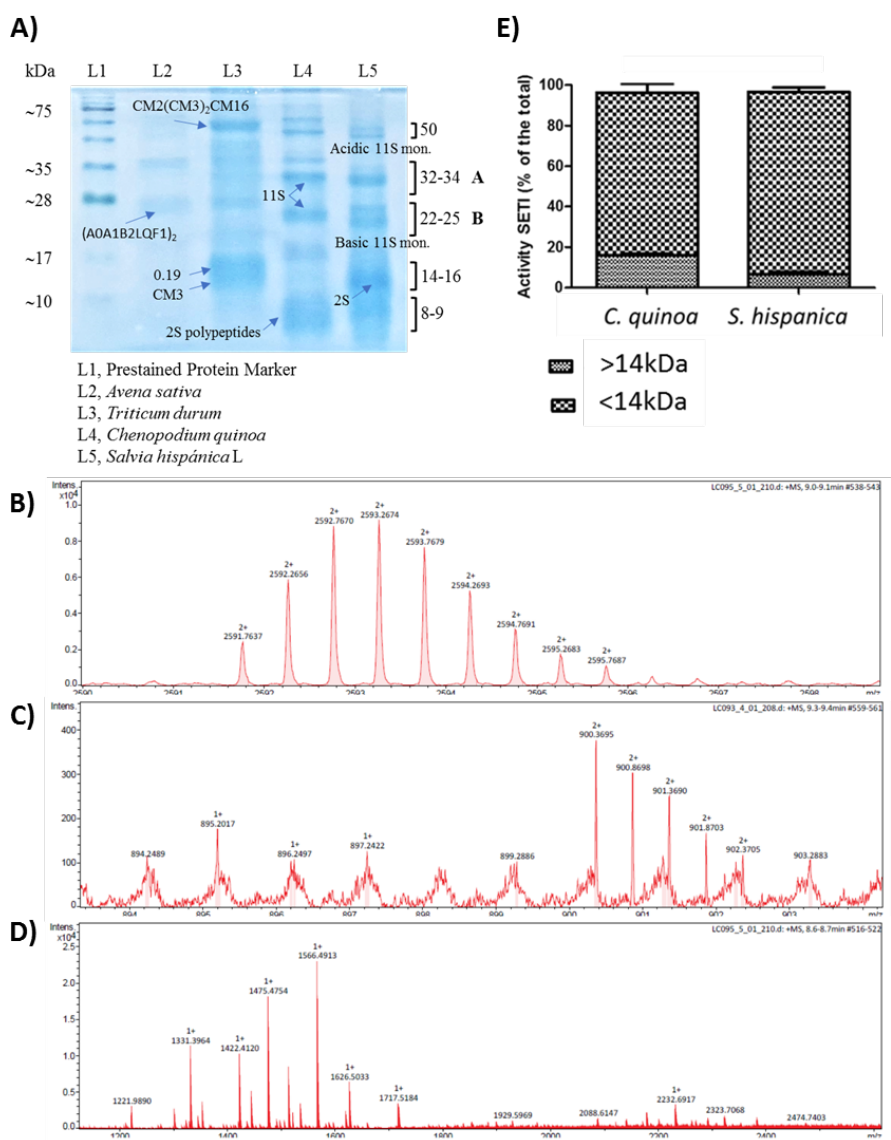
Figure 1. Electrophoretic (SDS-PAGE, 12%) pattern of salt soluble (pH 6) proteins from C. quinoa and S. hispanica ( A ), 11S storage protein that scaped postsynthetic processing ( B ), polypeptides from 2S-type proteins ( C ), oilseed 2S albumin ( D ), relative protease inhibitory activity in the < 30 kDa fraction obtained from C. quinoa or S. hispanica L. ( E ).